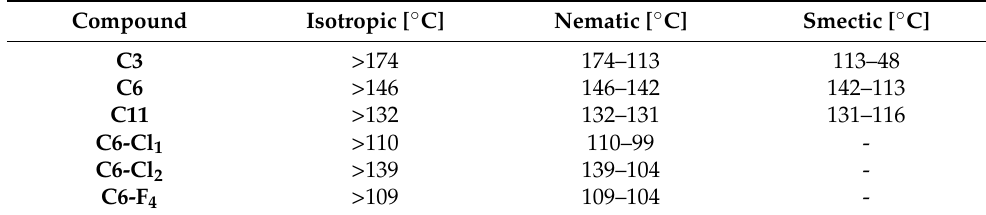
Table 2. Phase transitions of the synthesized